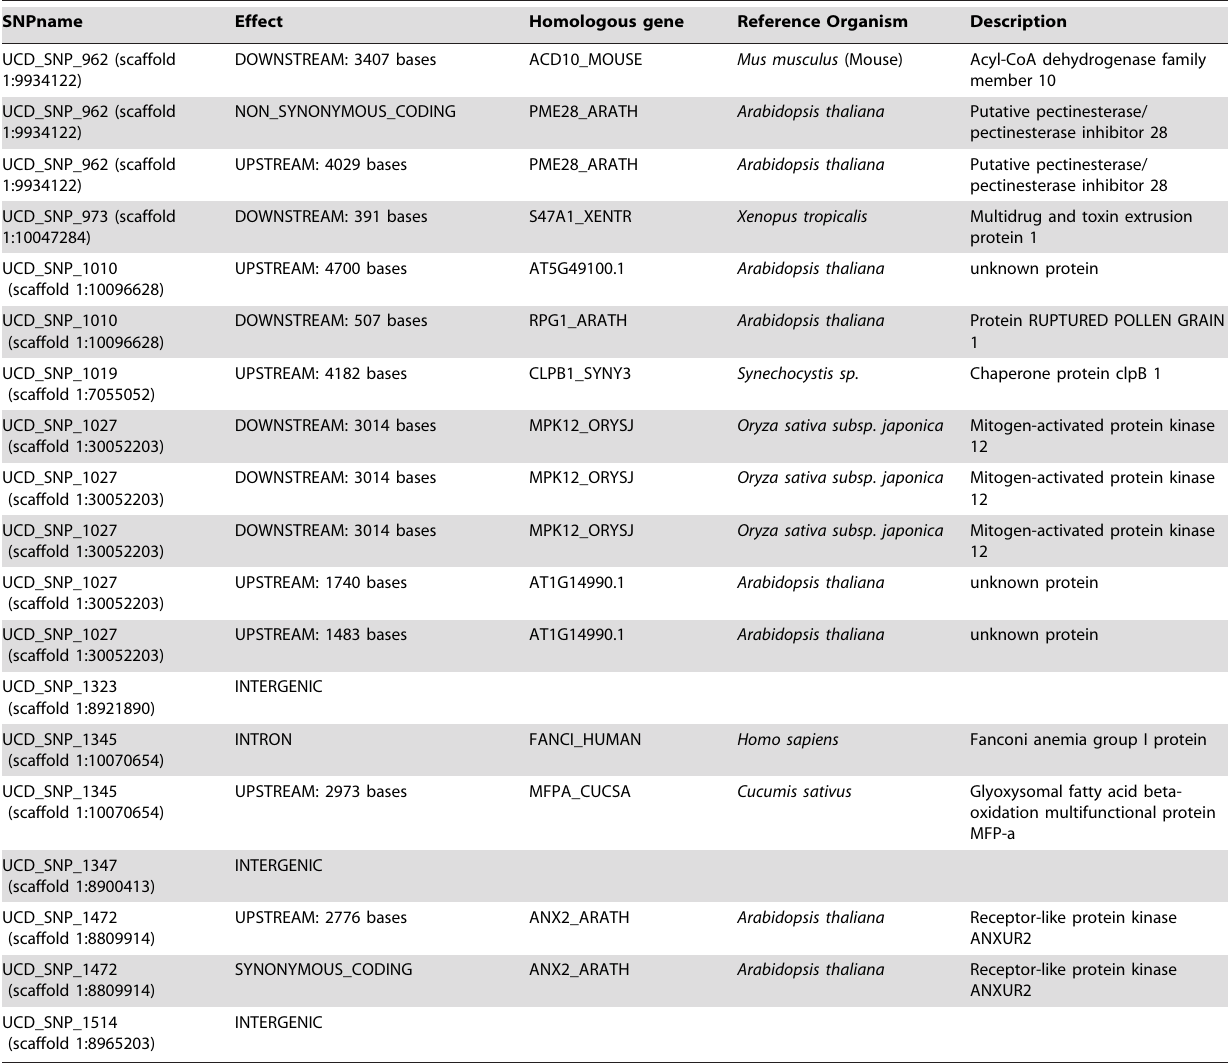
SNPname Effect Homologous gene Reference Organism